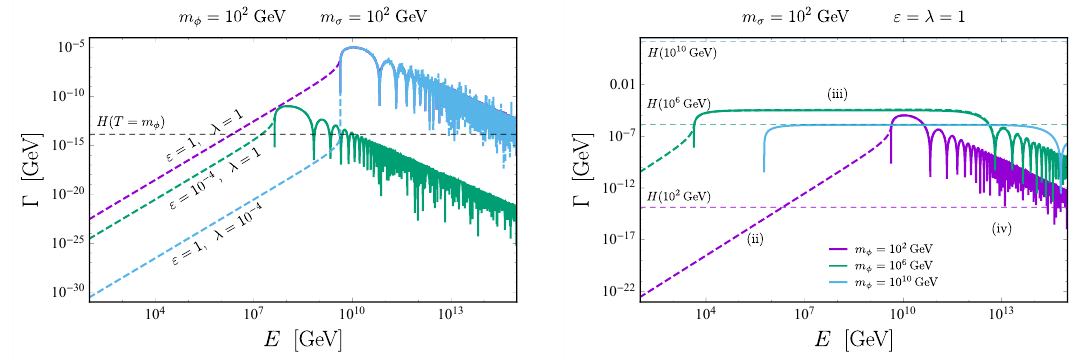
Figure 5 . The initial energy dependence of the zero mode decay width at the temperature T = m φ with various parameter sets. (Left) The purple, green, blue lines correspond to the parameters ( ε, λ ) = (1 , 1) , (10 − 4 , 1) , and (1 , 10 − 4 ) , respectively. The solid and dotted parts mean Γ and conv Γ (the purple-solid and blue-solid lines are overlapped). The mass parameters are fixed 2 -body m φ = m σ = 10 2 GeV . (Right) The purple, green, blue lines correspond to m φ = 10 2 , 10 6 and 10 10 GeV, while m is 10 2 GeV . The other couplings are fixed as ε = λ = 1 . In both figures, the σ horizontal dashed lines show the Hubble parameter at T = m . The regions (ii), (iii), (iv) imply the φ classification of the energy dependence of the width. See the text for